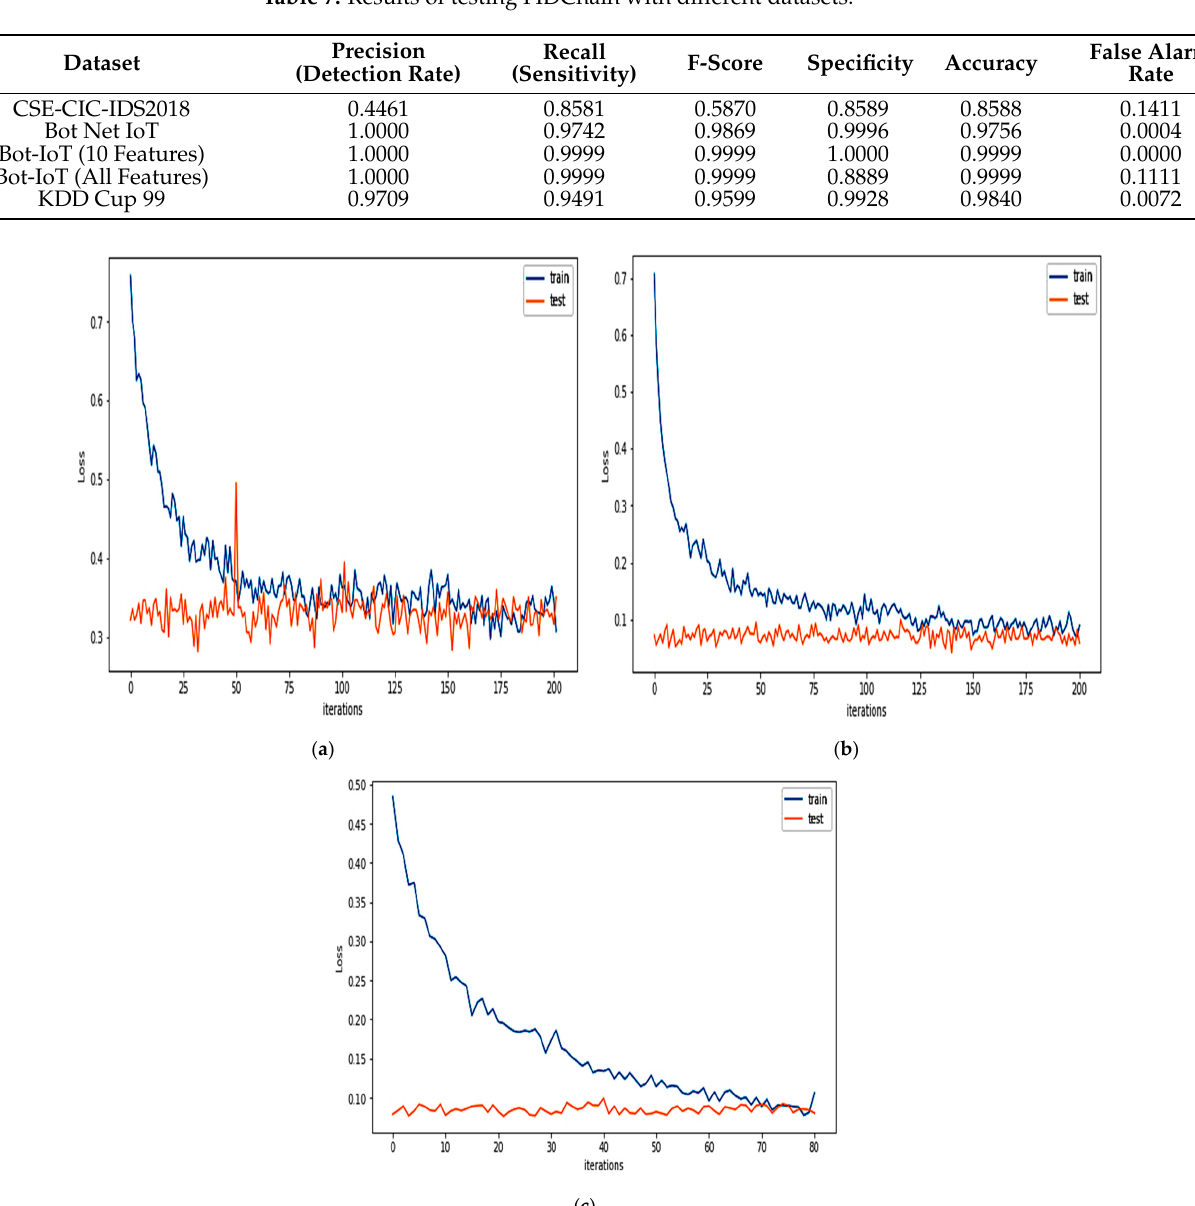
Table 7. Results of testing FIDChain with different datasets.